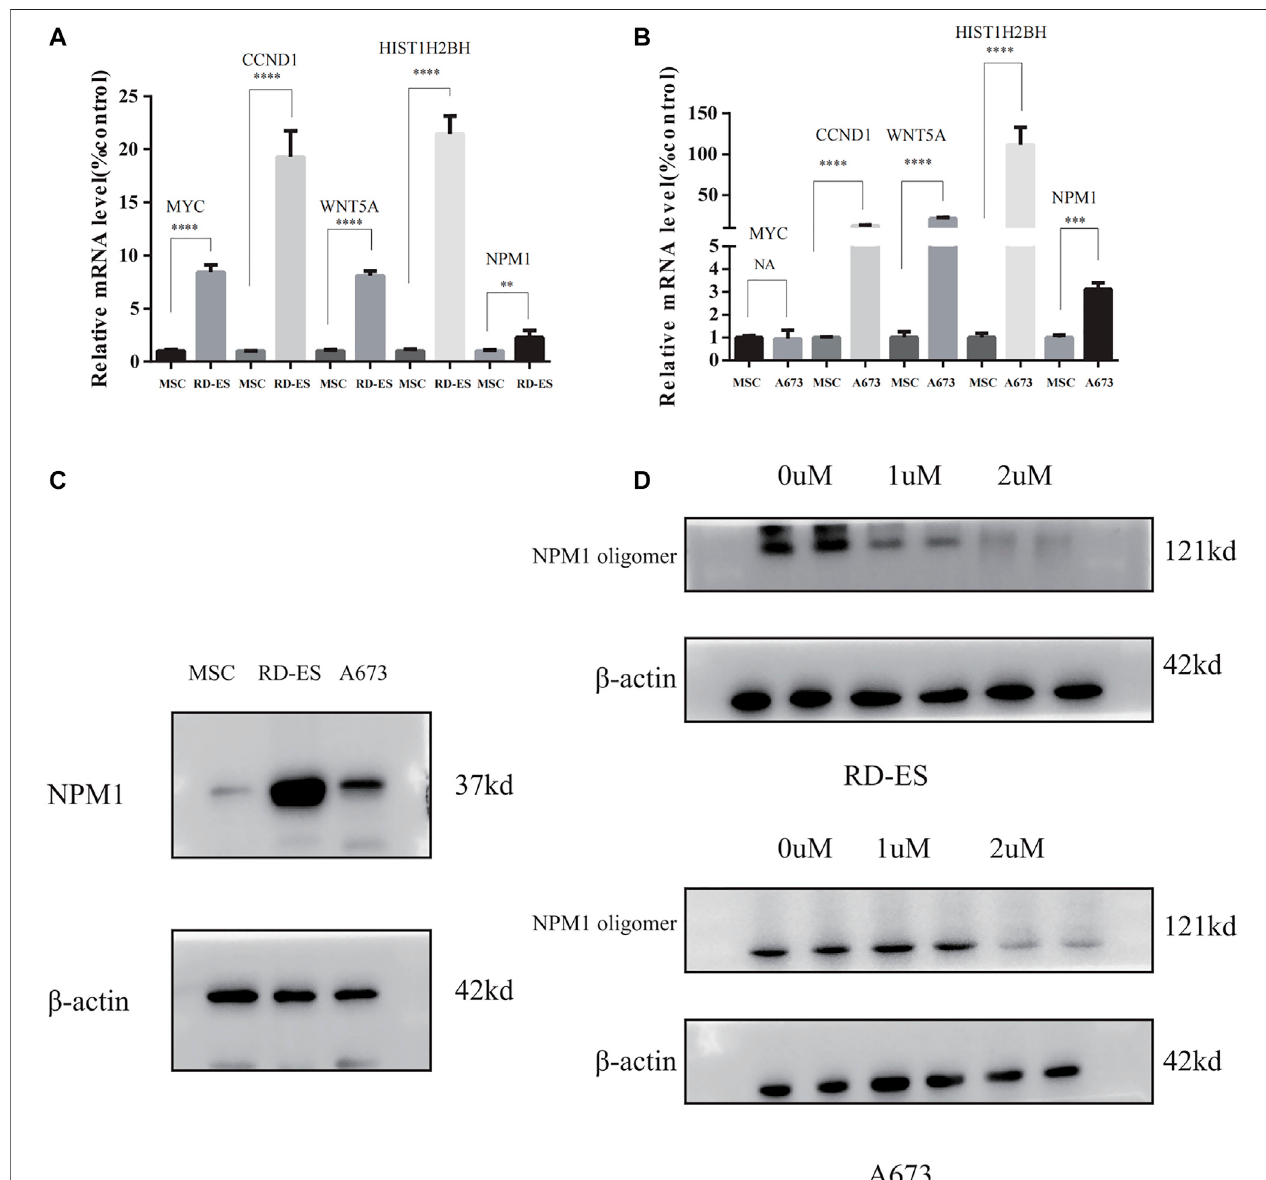
FIGURE 7 | (A,B) The mRNA expression of MYC, CCND1, WNT5A, HIST1H2BH, and NPM1 detected between mesenchymal stem cells (MSC), and Ewing sarcoma (ES) cell lines. (C) NPM1 protein expression levels were higher in RD-ES and A693 cells than in MSCs by western blotting. (D) RD-ES and A673 cells were treated with NSC348884 at 0, 1, 2 µM for 24 h and the results of western blotting showed that NSC348884 inhibits the formation of NPM1 protein oligomers (NA, p > 0.05; *, p < 0.05; **, p < 0.01; ***, p < 0.001; ****, p < 0.0001).